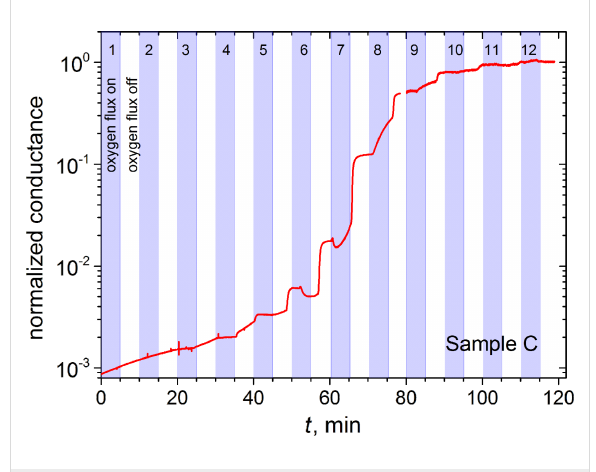
samples B and C lies in that they were originally designed for other measurements in addition to those reported here.